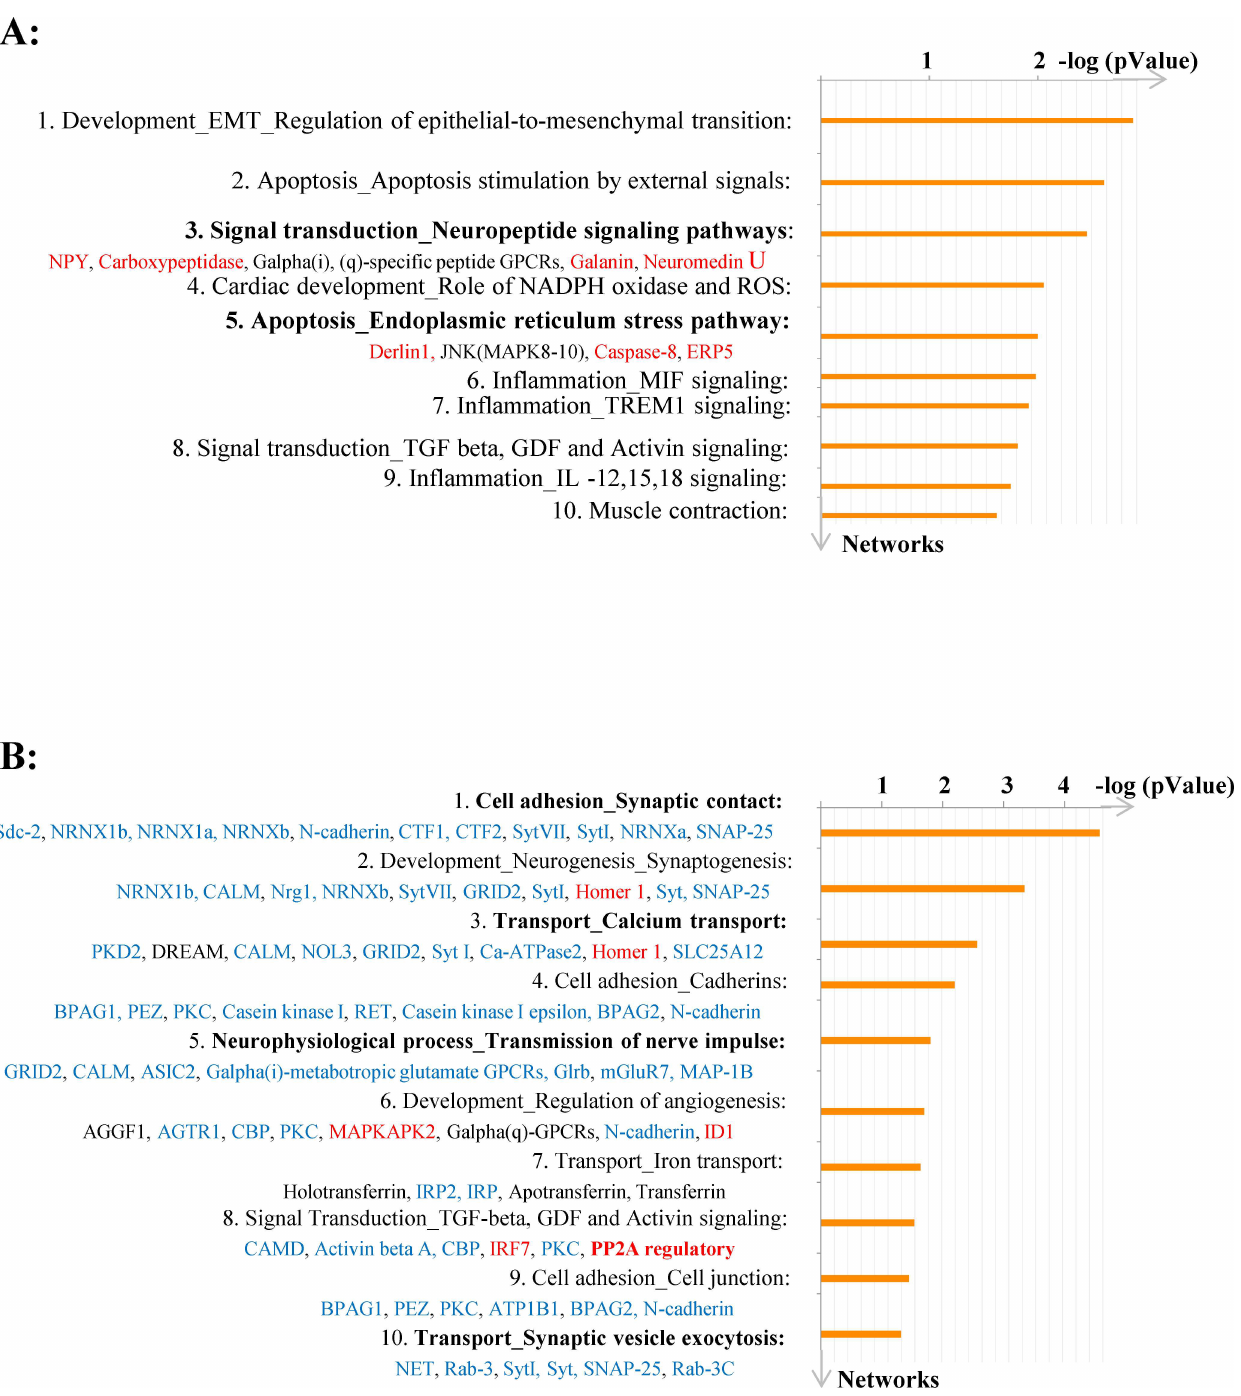
Fig 6. Enrichment analysis of DEGs in 2RH and 2RS experimental groups. A) Shownis the distribution by process networksat 0 time point (2RH0vs. 2RS0) and B) at 60 min time point (2RH60vs. 2RS60). Sorting is done for uniquegenes and both signals (induced genes—shown in red and repressed genes—in blue) included. Top 10 process networksare listed basedon their—log(p-value).For list of abbreviations see supplemental file S1 Text.